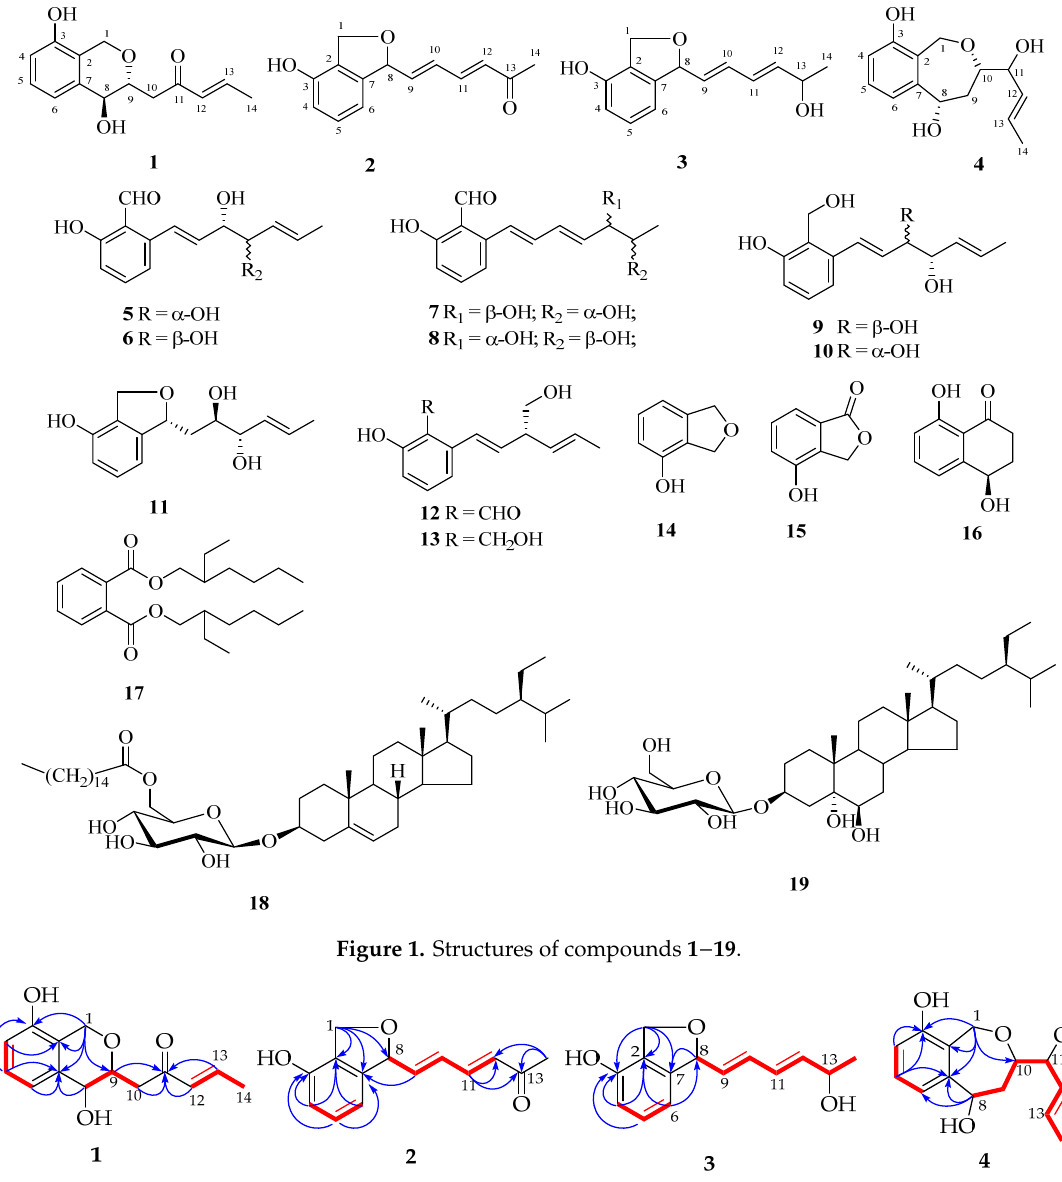
Figure 2. Selected HMBC ( ) and 1 H ‐ 1 H COSY ( ) correlations of compounds 1 – 4 . Table 2. 1 H and 13 C NMR Data of Compounds 3 and 4 ( δ in ppm, J in Hz).